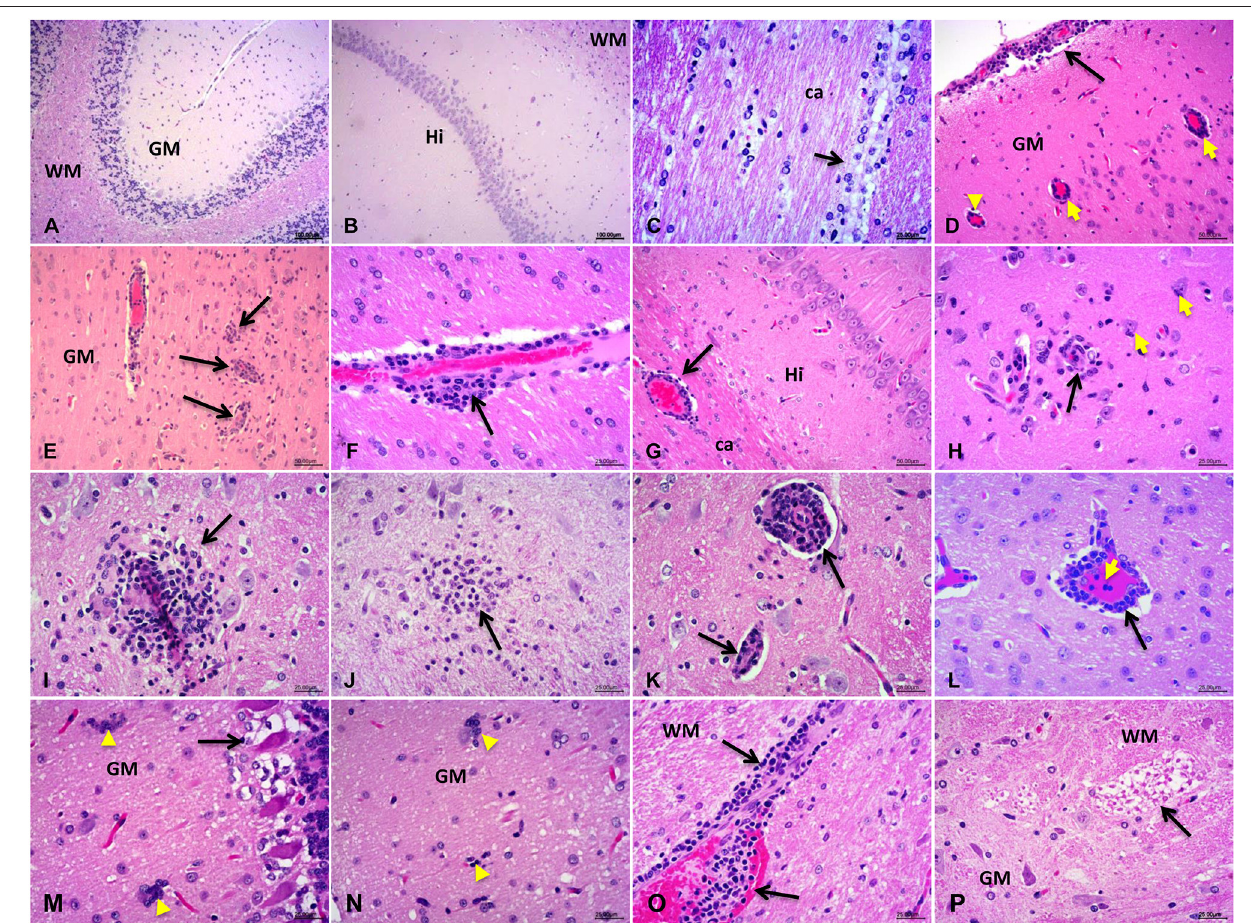
FIGURE 1 | Histopathological detection of the central nervous system (CNS). (A–C) The normal structure of the CNS tissue from control rabbits: cerebellum (A) the molecular layer and granular layers of the gray matter (GM), and pukinje cells and the white matter (WM); cerebrum (B) hippocampus (Hi) and (C) corpus callosum (ca) and the ependymal epithelium of the white matter (D–P). Various pathological changes observed in HEV-RNA positive brain sections, especially the characteristics of viral encephalitis include perivascular cuffs of lymphocytes and microglial nodules: cerebrum (D–I) : venous congestion of the Pia Mater, perivascular cuffs of lymphocytes and microglial hyperplasia in the cerebral cortex, corpus callosum (ca), brainstem, hypothalamus and the pons; cerebellum (M) degenerate and necrotic pukinje cells, (N) microglial nodules, and necrotic neurons surrounded and invaded by hypertrophic microglial cells (neuronophagia), (O) perivascular cuffs